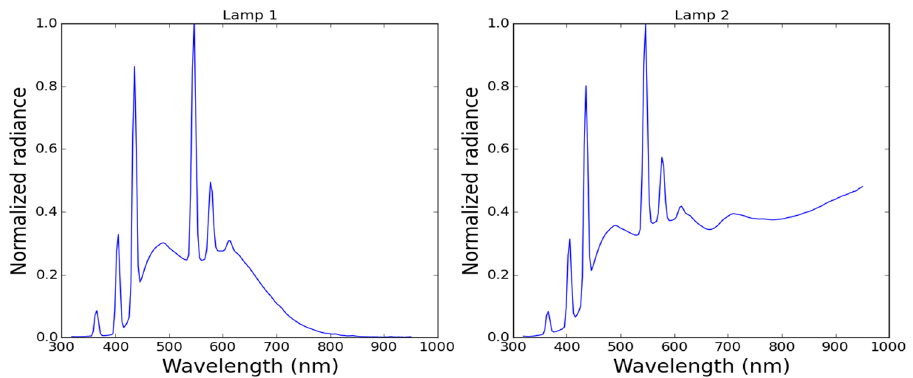
Figure 12. Lamp spectra of the experimental tank.